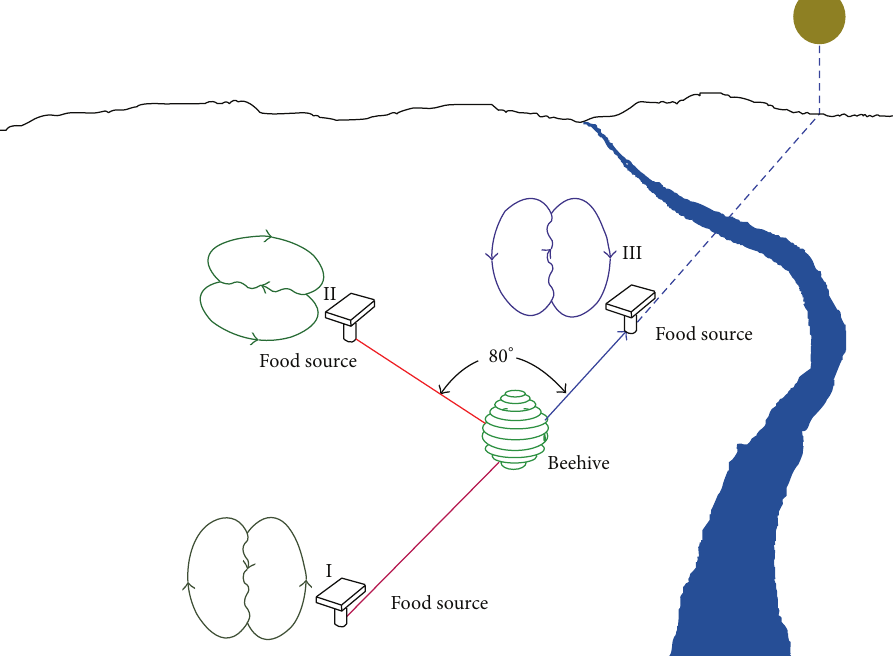
Figure 1: Honeybees communication through dances [32]. Table 1: Division of labor for honeybees [32, 33].